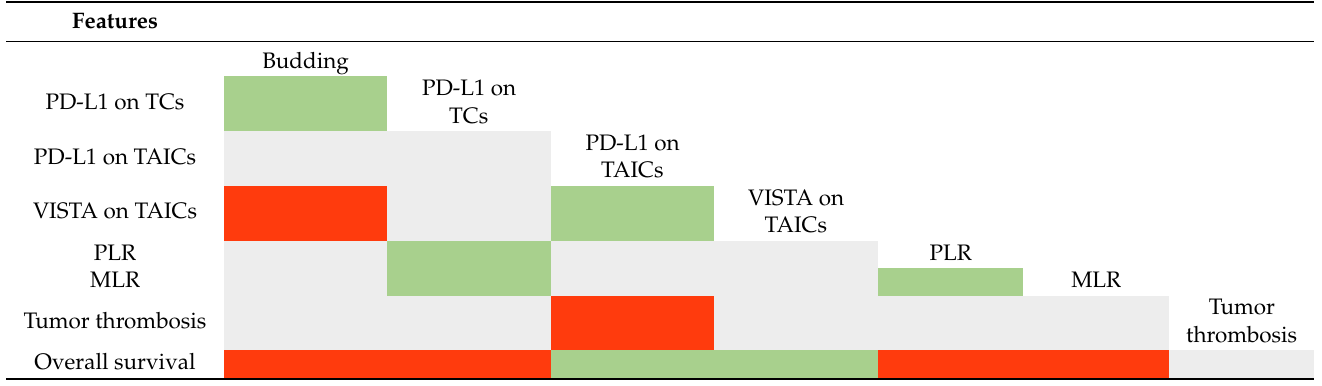
Table 5. The summary of correlation between analyzed parameters. Green depicts positive correlation, red depicts negative correlation, and grey means no significant